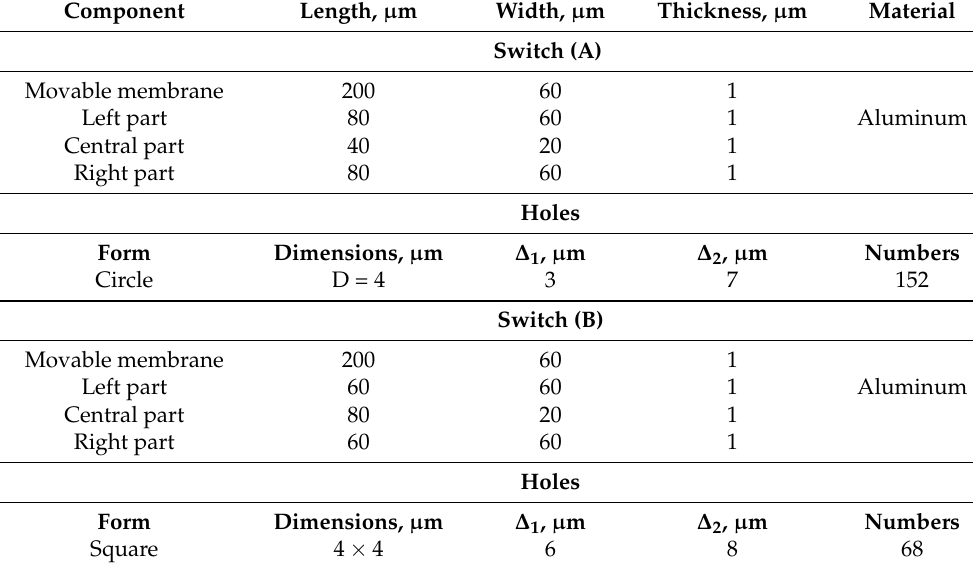
Table 6. Specification of the movable membranes of switch (A) and switch